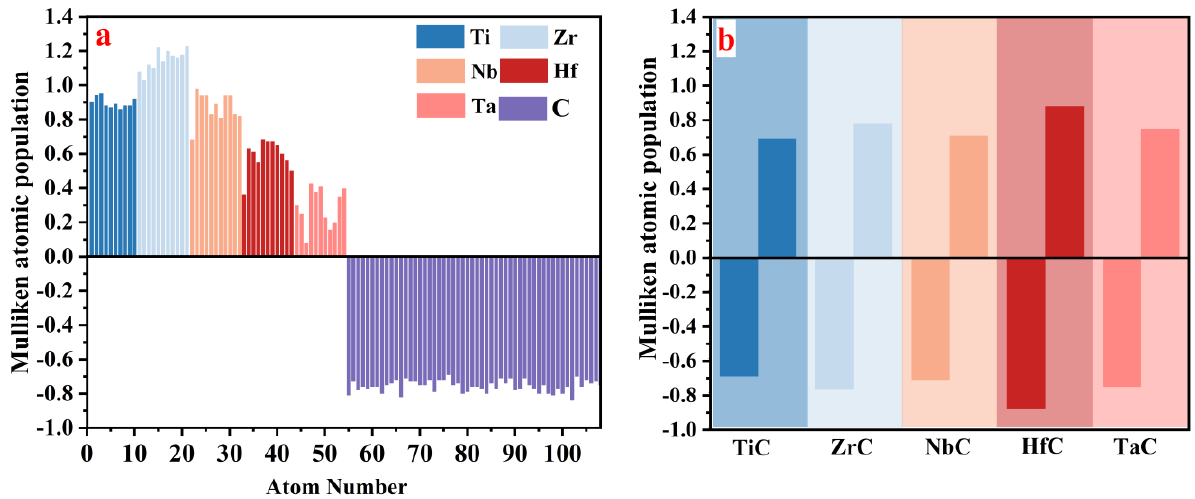
Figure 5. The Mulliken atomic population distribution for ( a ) HEC and ( b ) an individual